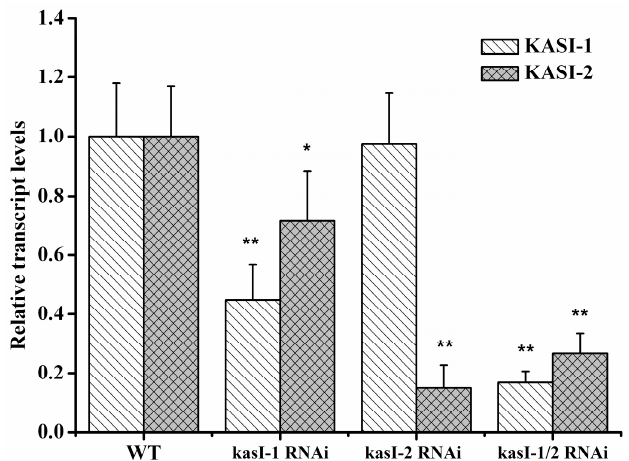
Figure 5. Relative transcript levels of KASI genes in the silence lines and WT tobacco. The expression of NtKASI-1 and NtKASI-2 gene in the 9th and 10th leaves in medium stage of wild type, kasI-1 RNAi, kasI-2 RNAi and kasI-1/2 RNAi lines using qRT-PCR. The error bars represent the standard error with four independent lines. The asterisk above the bars indicates the significant differences between the silence plants and WT (* p < 0.05, ** p < 0.01).